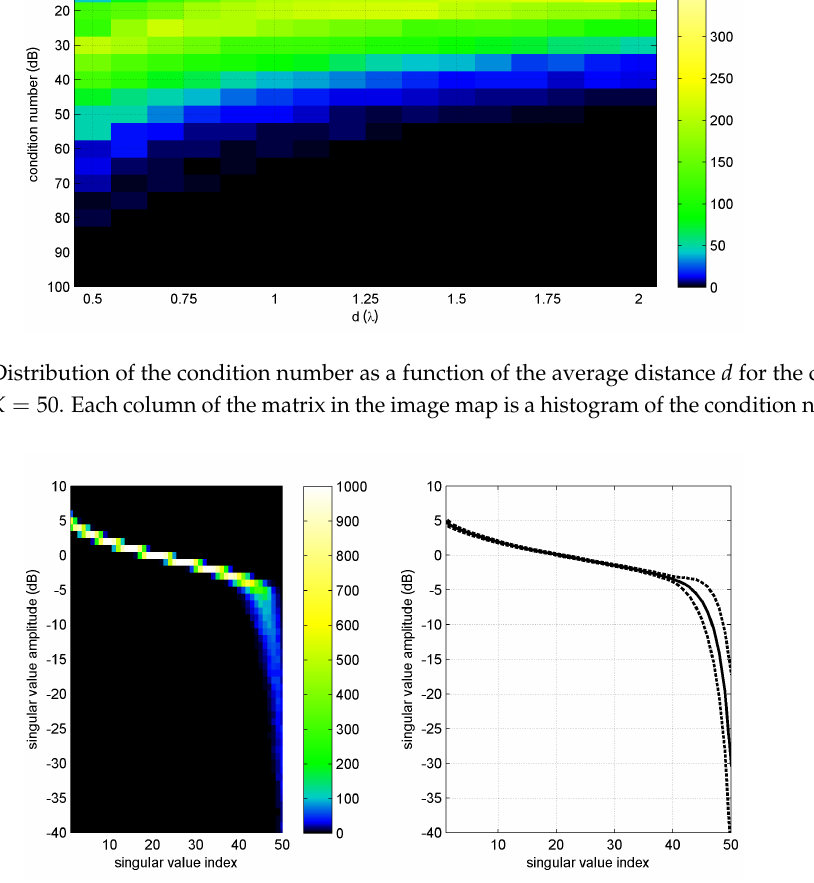
Figure 18. Singular values analysis for the circular array with d = λ /2 and K = 50. ( Left ) Image map of the distribution of each one of the 50 singular values. ( Right ) solid line, average singular values; dashed lines, average singular values ± the standard deviation of the distribution.